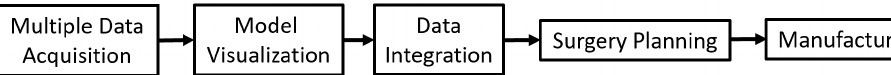
Figure 1. Schematic of virtual surgery planning procedure.